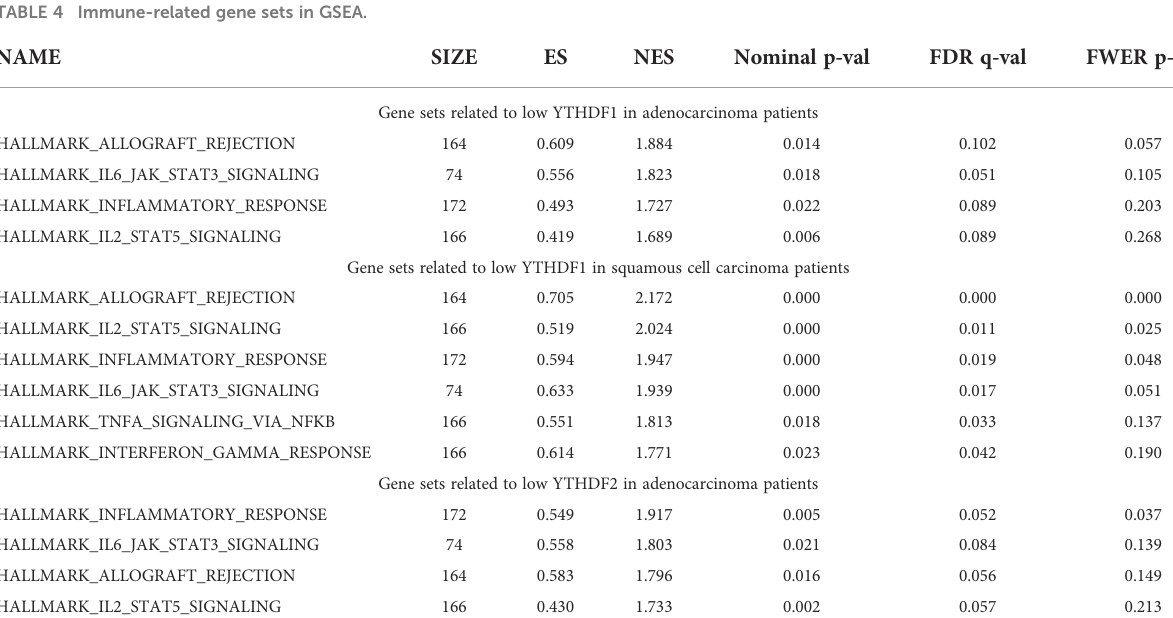
TABLE 4 Immune-related gene sets in